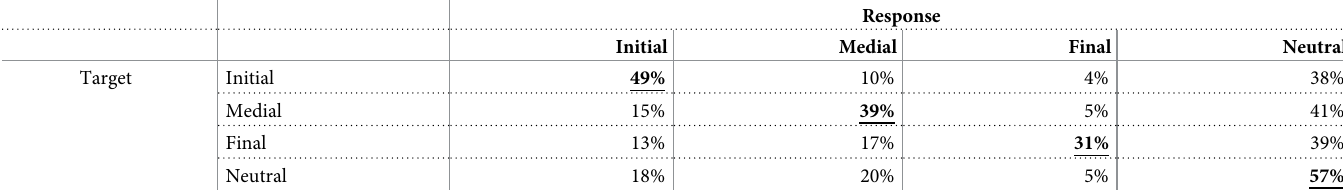
Table 4. Confusion matrix summarizing mean response rates in Experiment